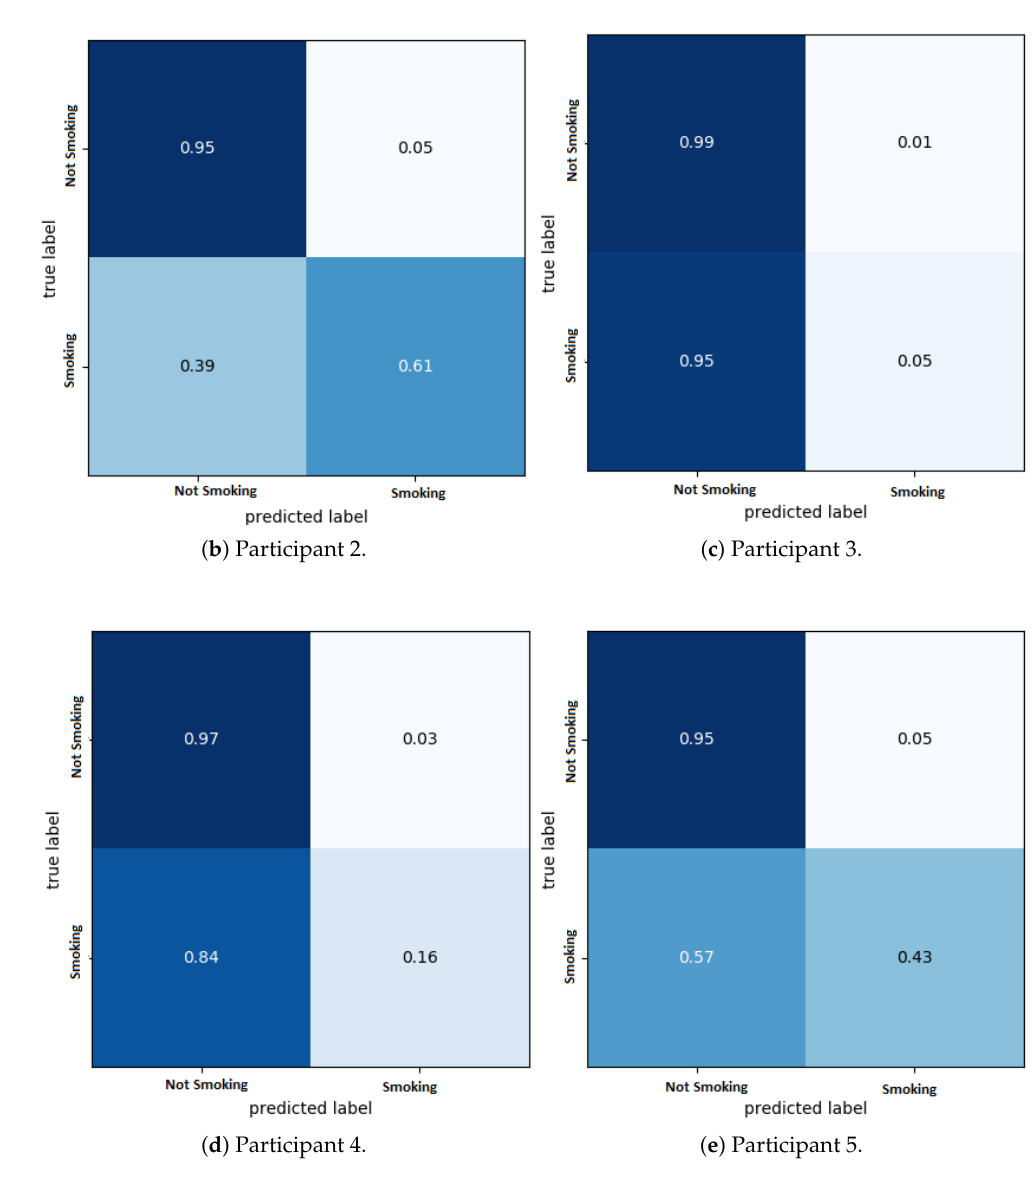
Figure 10. 1D-CNN model confusion